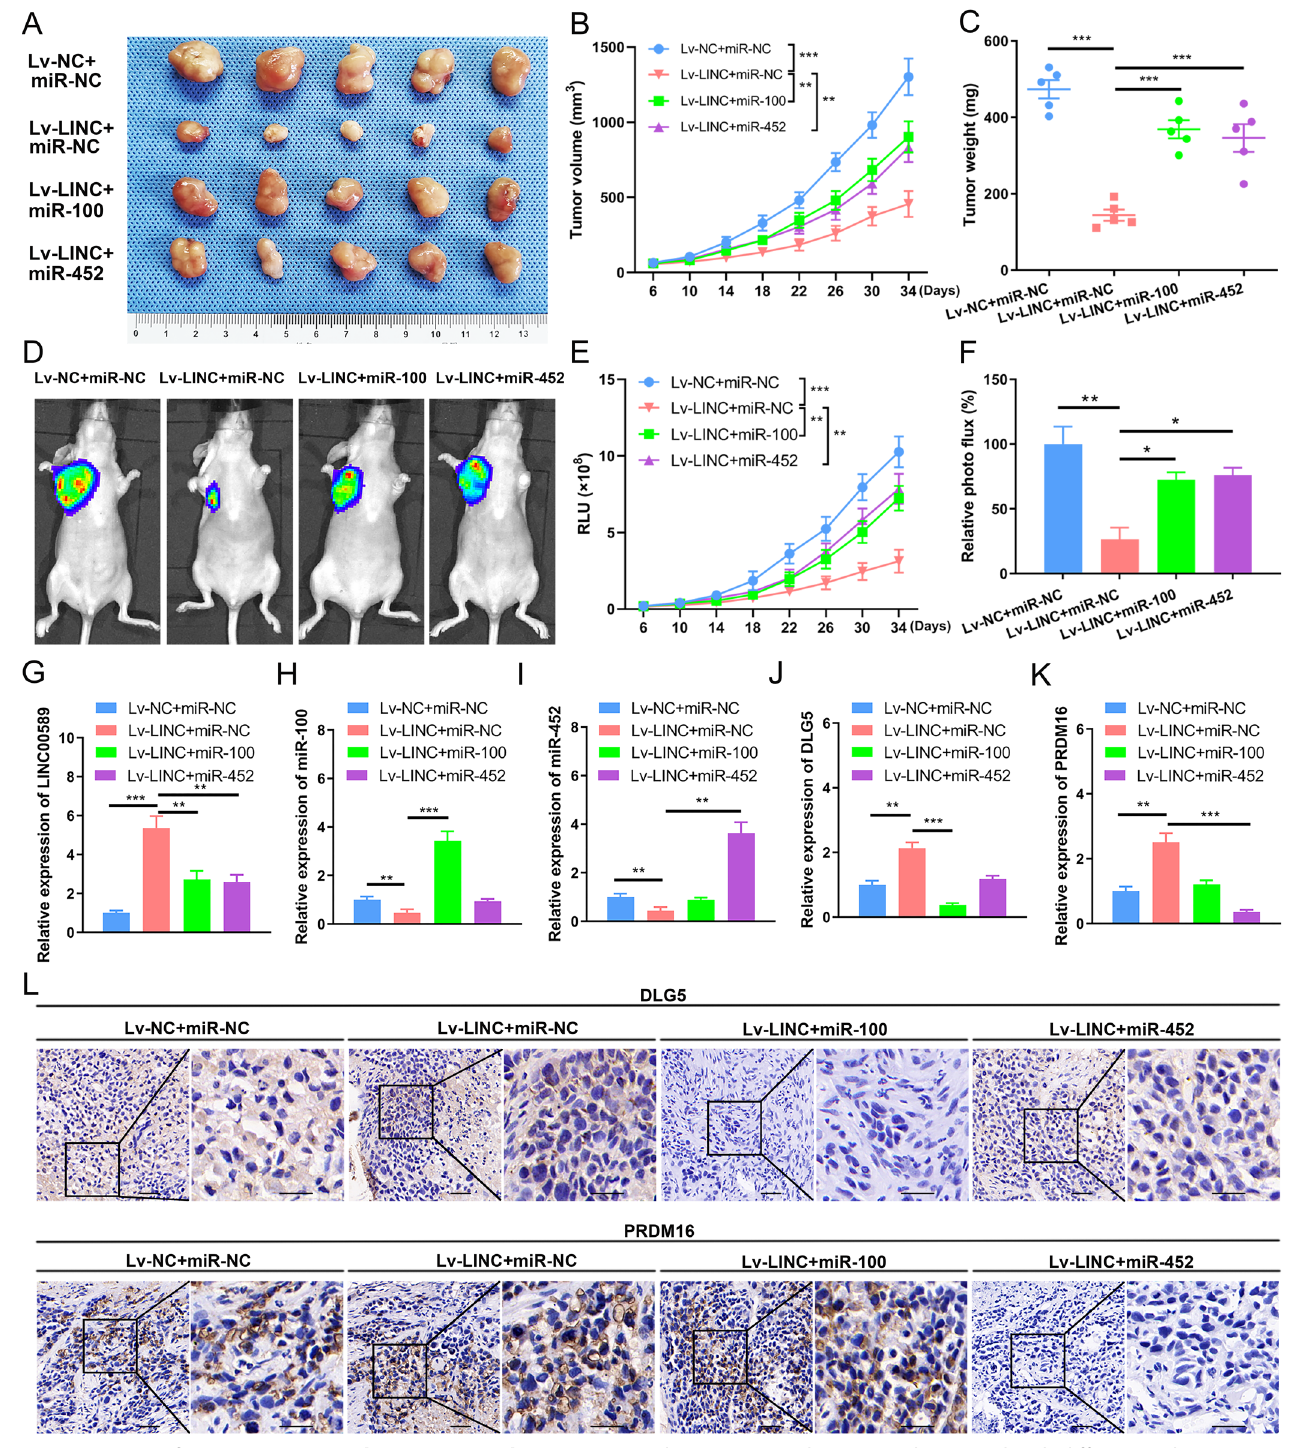
Fig. 8 Function of LINC00589 initiated ceRNA networks in vivo. A Nude mice were subcutaneously injected with different TR breast cancer cells with different treatments, including Lv-NC, Lv- LINC00589 , miR-NC, miR-100 mimic, or miR-452 mimic, ( n = 5). Images of tumors dissected from four groups of nude mice at the end of the experiment are shown. B The tumor volume was recorded at the indicated days. C Final weights of tumors resected from all groups of sacri fi ced mice. D – F Nude mice were implanted with the indicated TR cells ( n = 5). Whole-body fl uorescent images were obtained at the indicated time intervals after injection ( D ), the luciferase activity at different times ( E ) and at the end ( F ) was calculated. Data are represented as mean ± SD and were analyzed by two-way ANOVA. G – K Expression of LINC00589 ( G ), miR-100 ( H ), miR-452 ( I ), DLG5 ( J ), and PRDM16 ( K ) in tumor tissues from the xenografts were determined by qRT-PCR assay. L Protein expression of DLG5 and PRDM16 in tumor tissues from the xenografts were analyzed by immunohistochemistry (IHC). Represent images are shown. Scale bar 50 μ m. Data are shown as mean ± SD; two-tailed t test was used to analyze the data in ( J , K ). * P < 0.05, ** P < 0.01, and *** P < 0.001 versus negative control